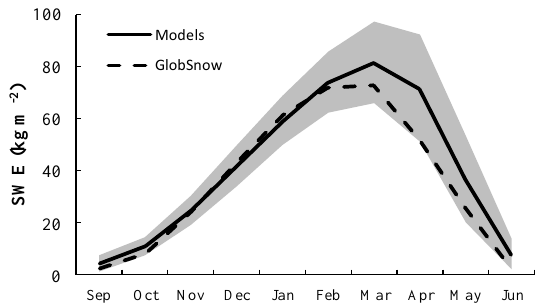
Figure 5. Area mean (1986–2005) seasonal cycle of SWE from eight models (asterisk-marked models in Table 1. dashed line for the multi-model mean and shading for ± mean 1 standard devia- tion) and from the GlobSnow data.